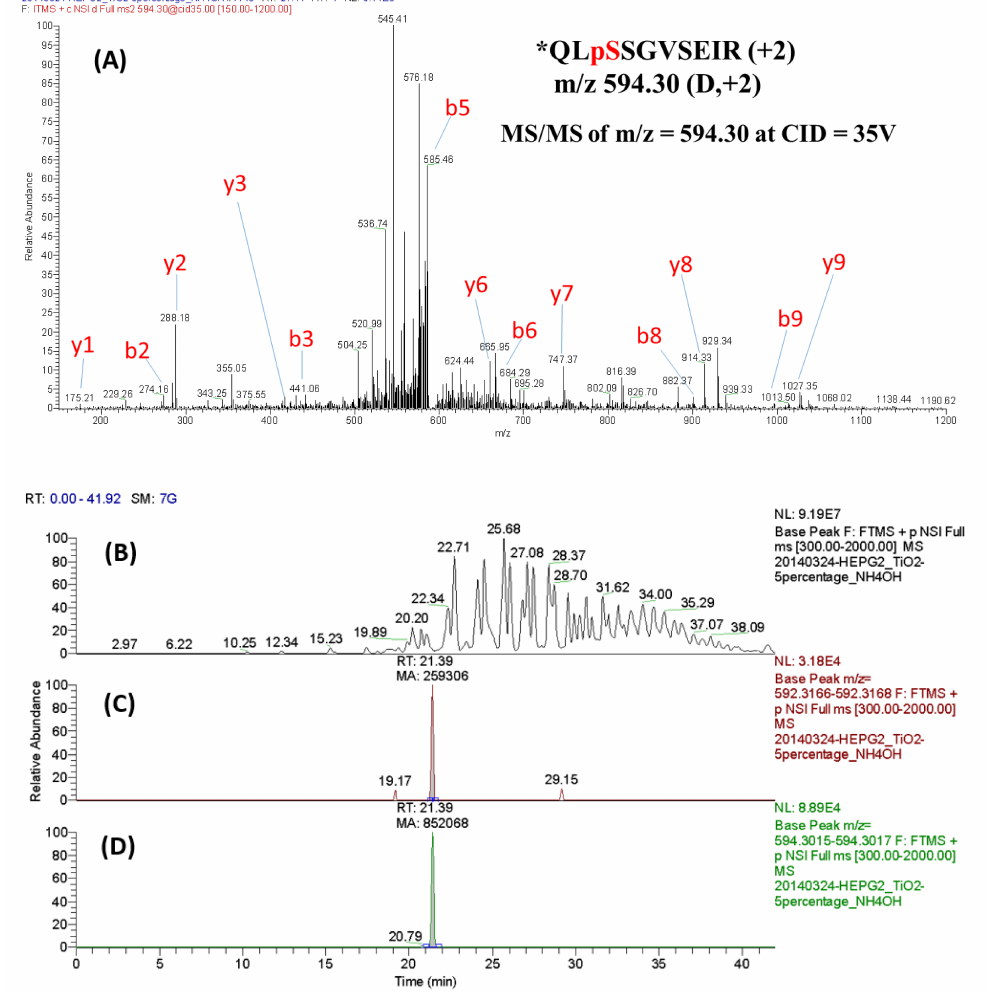
Figure 5. Relative quantitation of the phosphorylation degree of QLpSSGVSEIR (pQR-10) changed by oxidative treatment. ( A ) The MS / MS (LTQ Orbitrap) spectrum of D-labeled pQR-10 ( m / z 594.30, + 2); ( B ) the full LC-MS chromatogram of TiO 2 -enriched fraction; and ( C ) and ( D ) are the SIC of H- and D-labeled pQR-10, respectively. “*” marks the dimethyl labeling